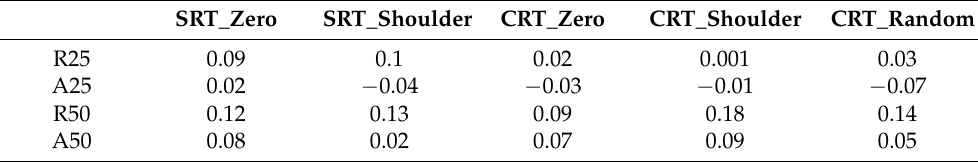
Table 2. Correlation (correlation coefficient, r ) between stereopsis and eye–hand response time ( n =